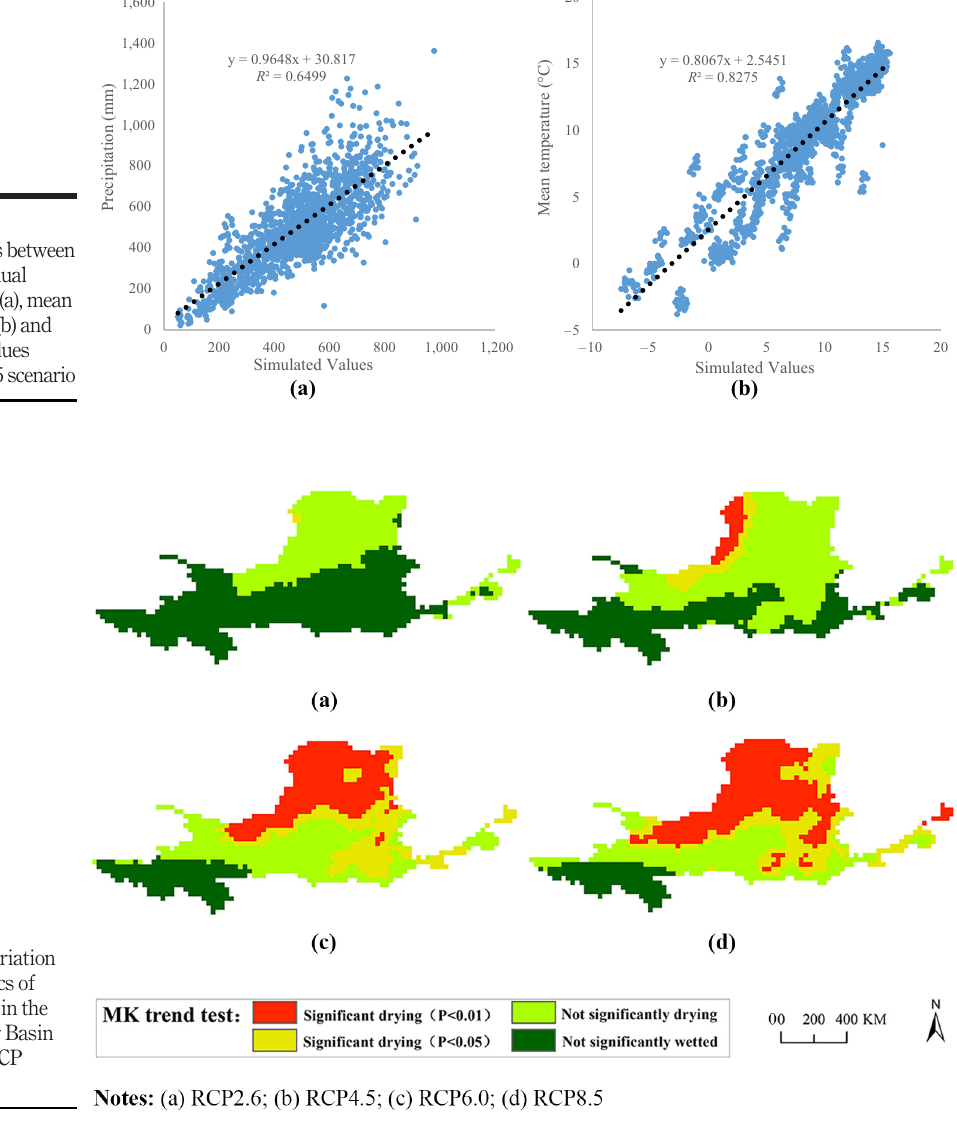
Figure 3. Temporal variation characteristics of annual SPEI in the Yellow River Basin under four RCP